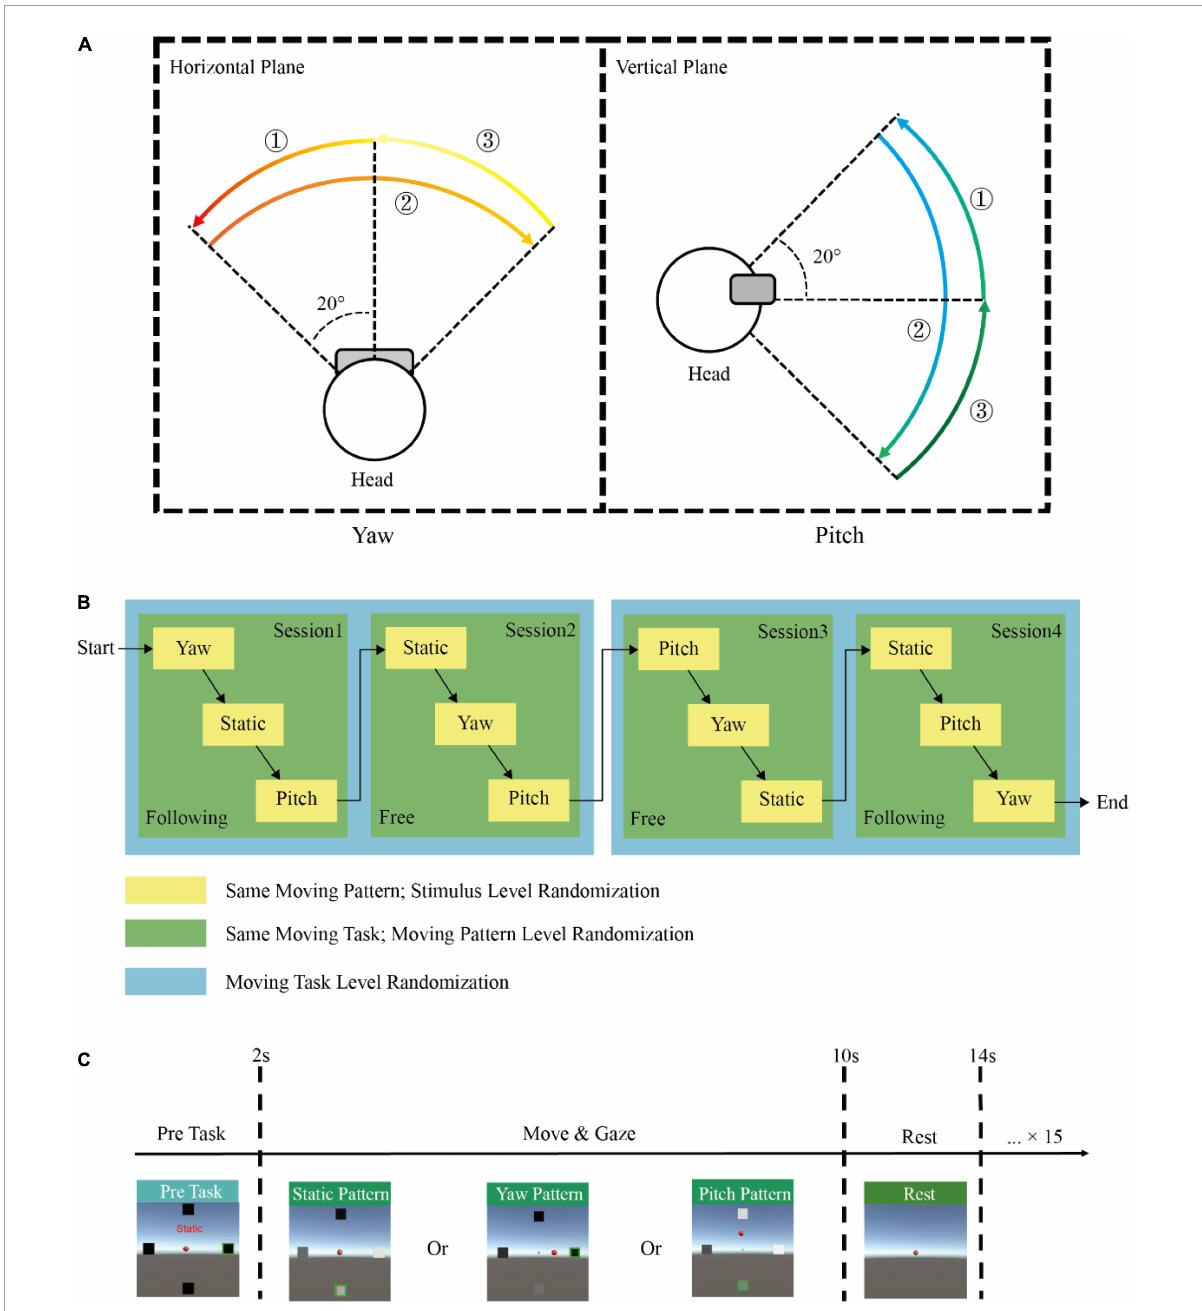
FIGURE2 Experimental paradigm. (A) The moving range and orders (encircled numbers) when a subject performs yaw and pitch moving patterns. (B) An example of the experimental protocol by the block randomization design. (C) The demonstration of one single trial in this experiment.